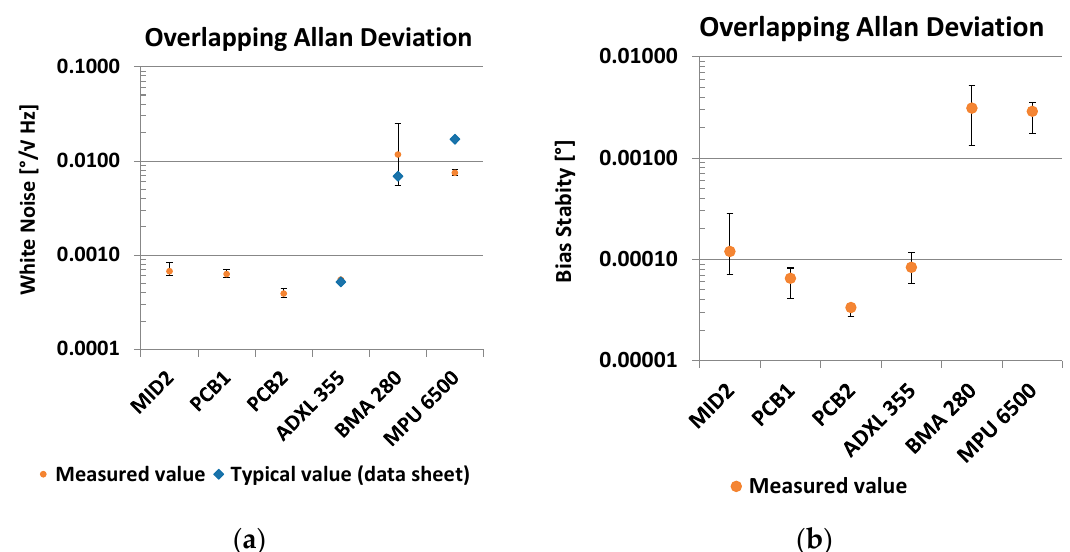
Figure 18. Allan deviation: ( a ) White noise; ( b ) Bias stability